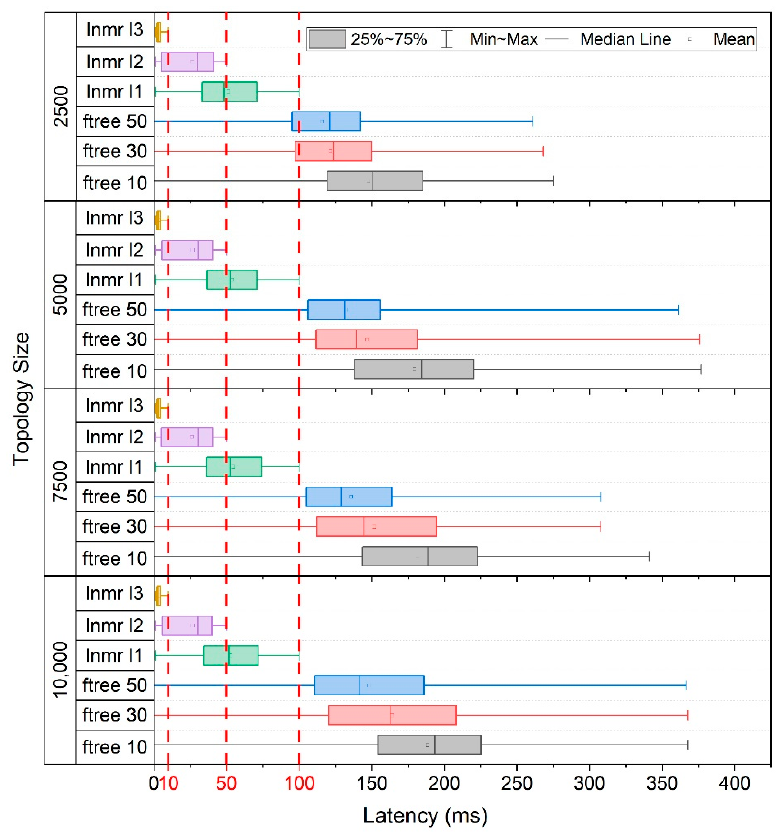
Figure 16. Response latency of LNMRS and Ftree.